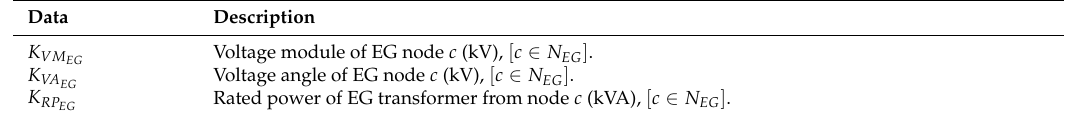
Table 13. Summary of input data (EG parameters).